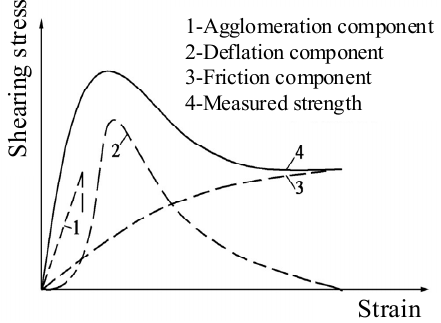
Figure 16. The shear strength mechanism of the soil